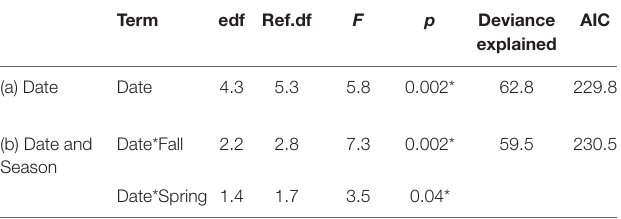
TABLE 2 | Generalized additive models (GAM) used for the temporal assessment of sediment plume size.